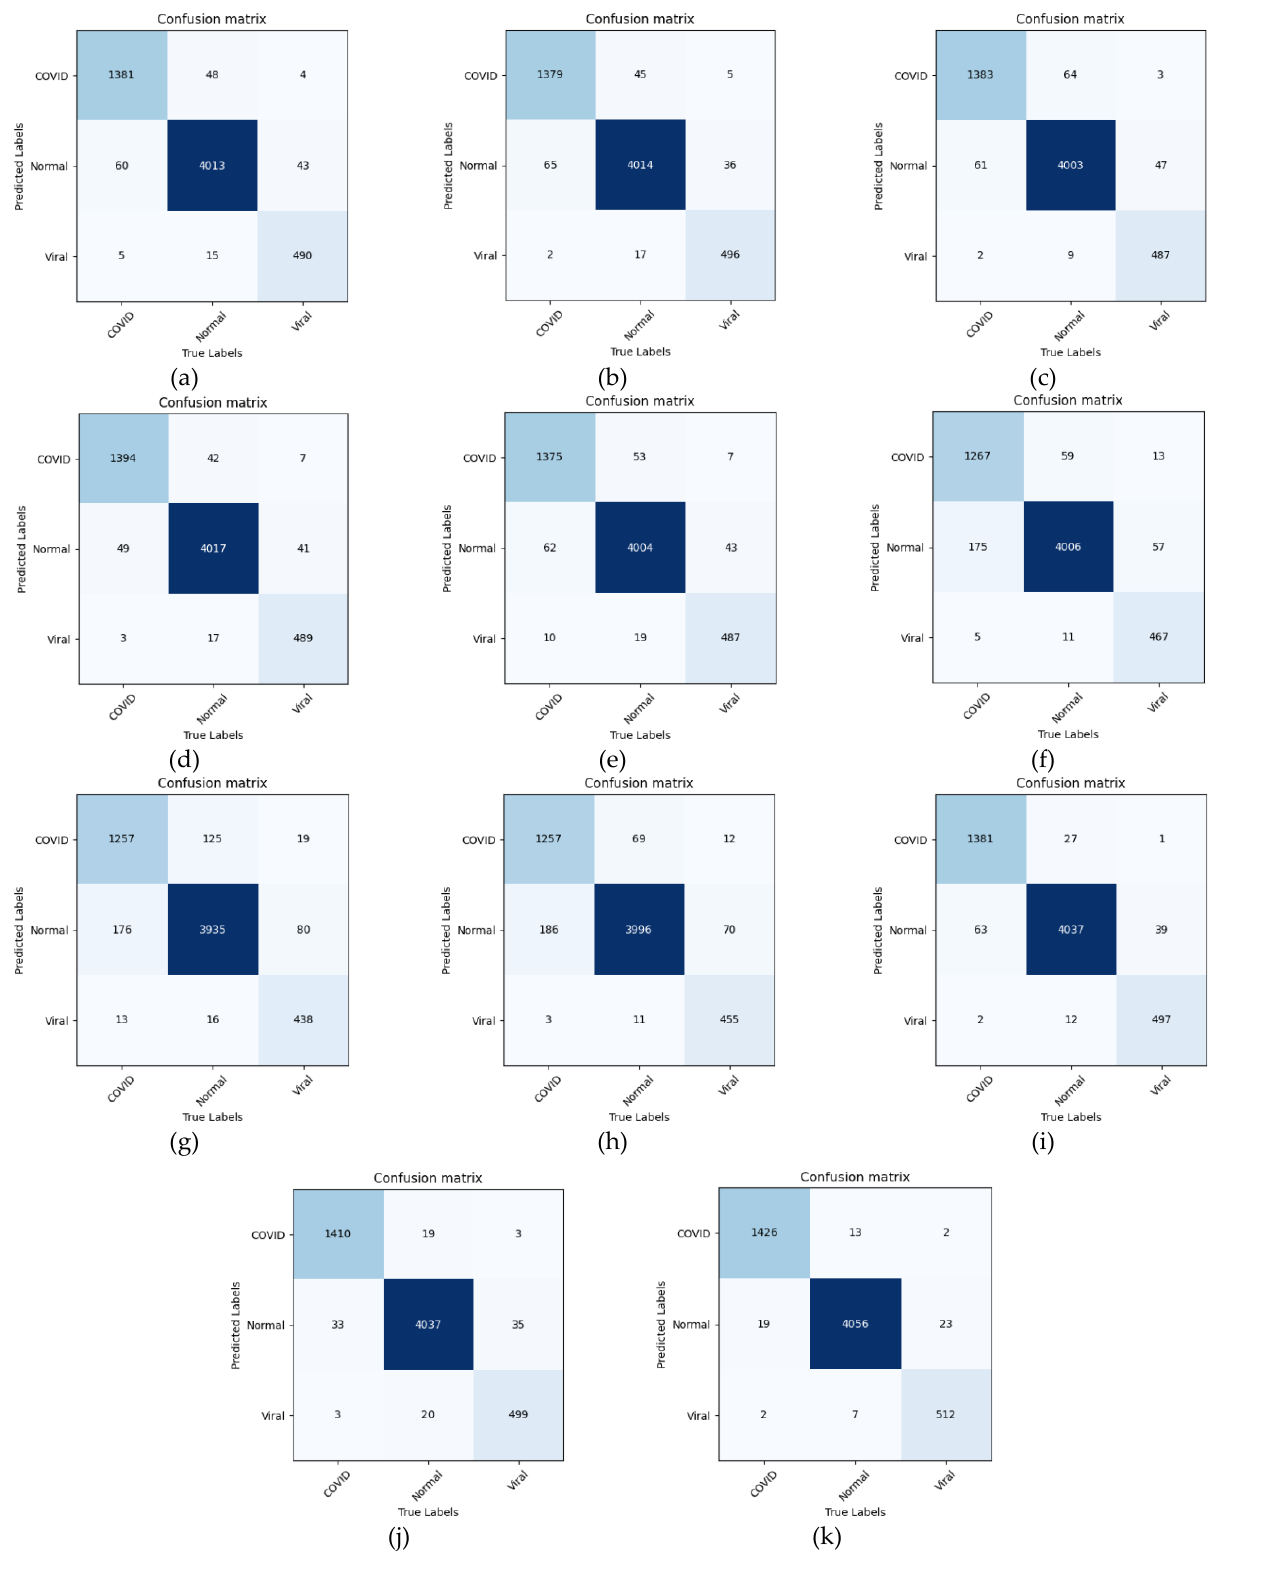
Figure 4. The confusion matrix on the test set of the COVID-19 Radiography database. (a) VGG16; (b) ResNet50; (c) DenseNet121; (d) [41]; (e) [42]; (f) [43]; (g) ViT; (h) Swin Transformer; (i) Uniformer; (g) AlterNet; (k) BoT-ViTNet.